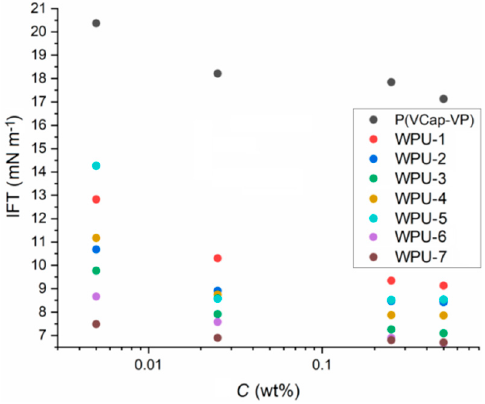
Figure 4. Interfacial tension (IFT) results for polyurethanes and P(VCap-VP) solutions.